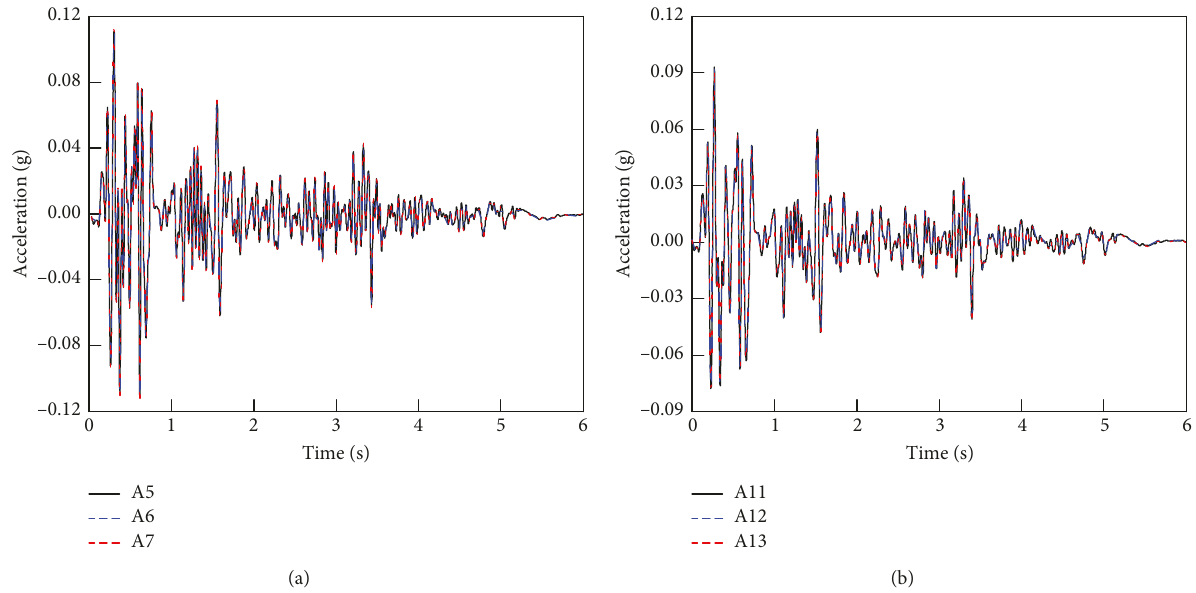
Figure 11: Time histories of acceleration for the accelerometers in case C7. (a) A5–A7. (b) A11–A13.